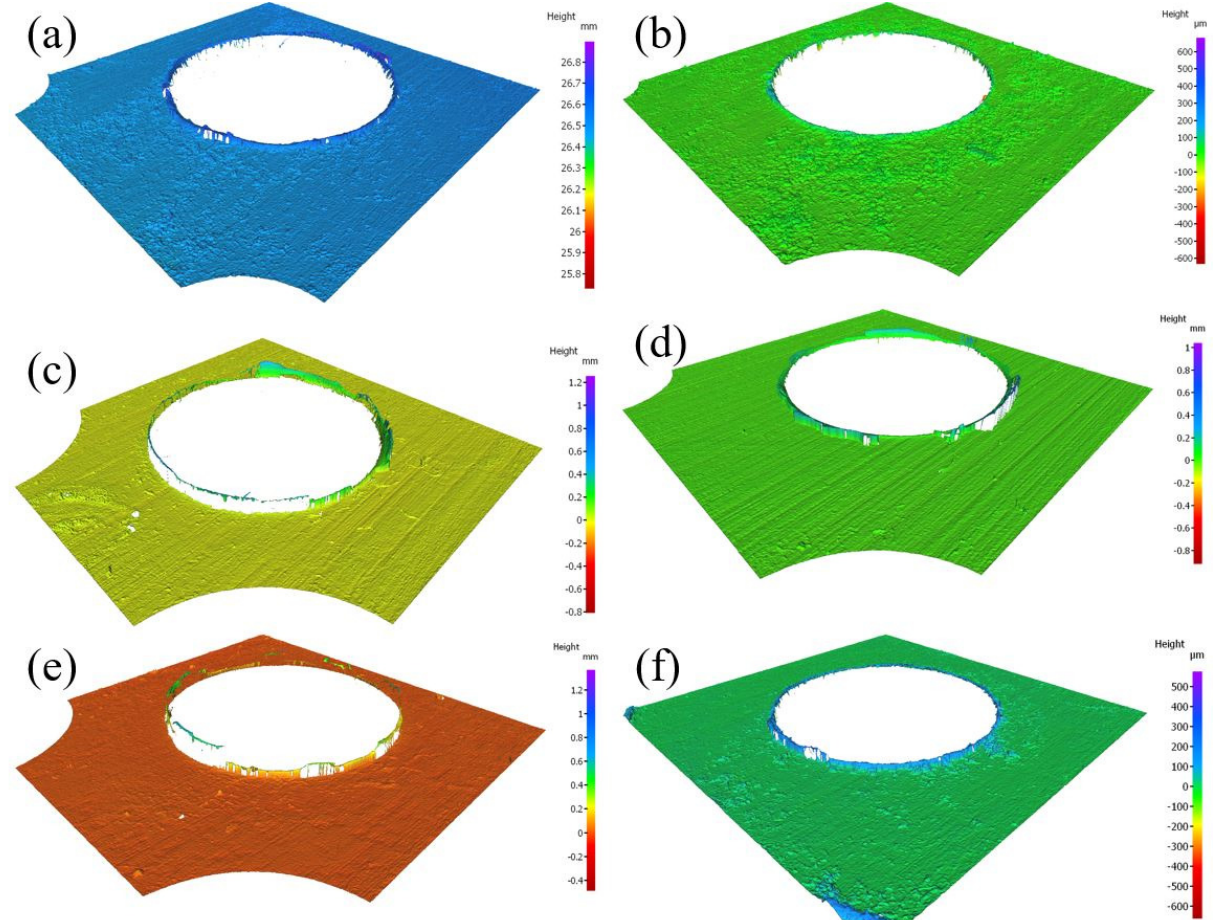
Figure 16. Effect of tool wear progression on the burr height at N = 3000 rpm for different machining parameters: ( a ) CD at first hole, ( b ) CD at hole number 50, ( c ) A m = 0.1 mm at first hole, ( d ) A m = 0.1 mm at hole number 50, ( e ) A m = 0.25 mm at first hole, and ( f ) A m = 0.25 mm at hole number 50.